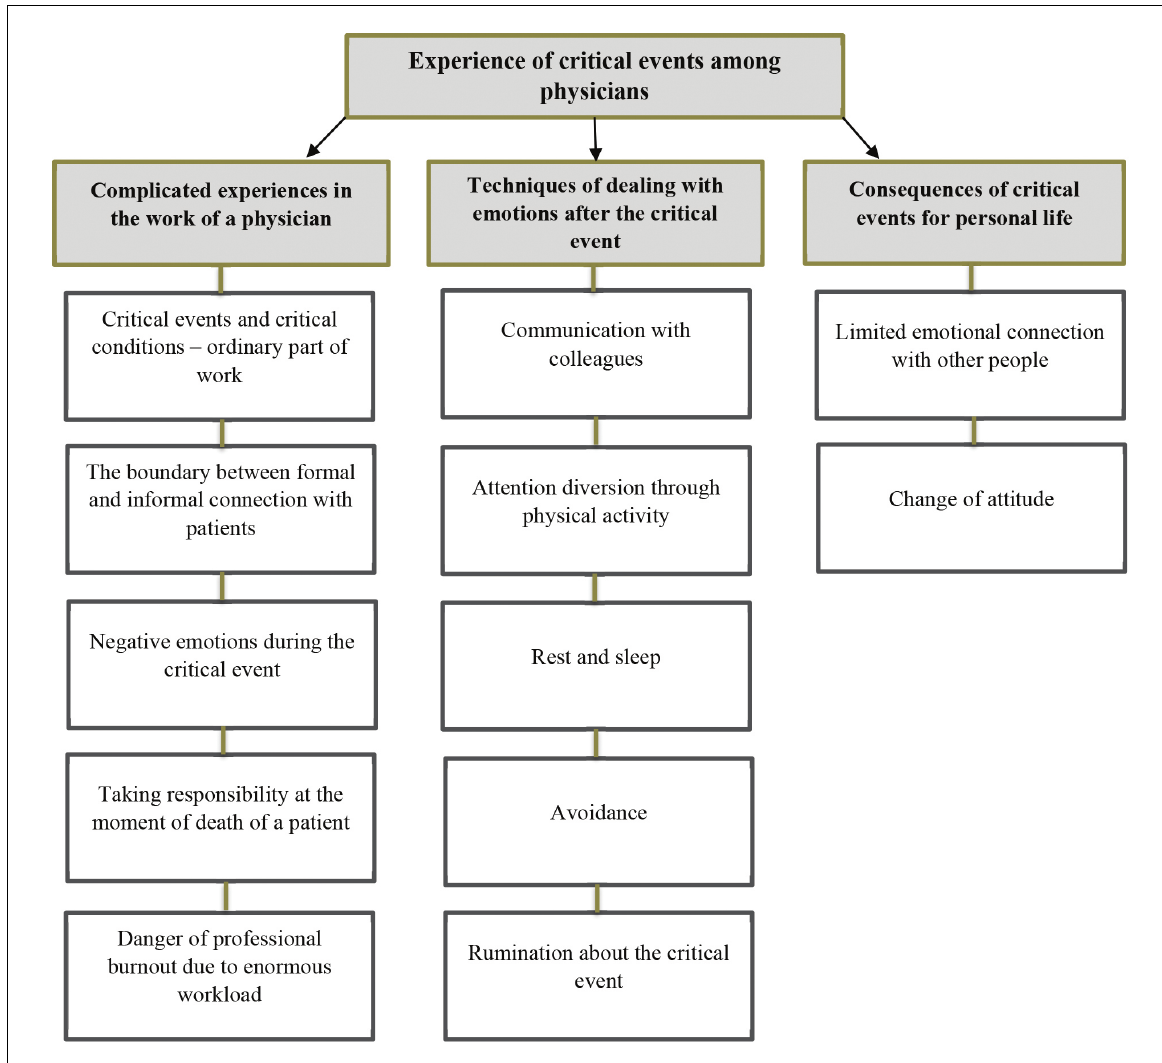
Figure. Results of thematic analysis: Major themes and